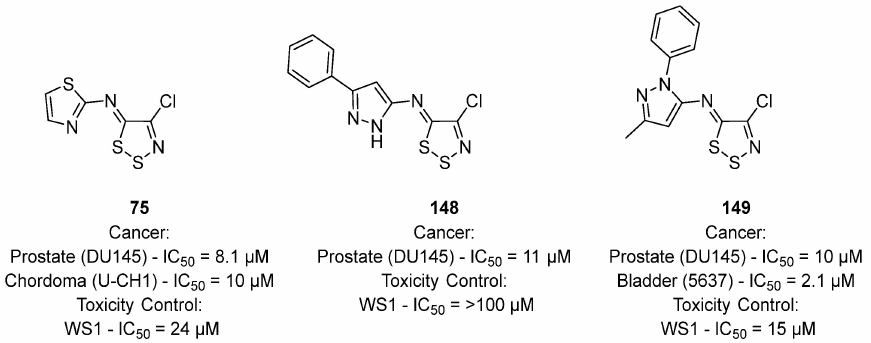
Figure 35. 5-membered heteroatomic analogues highlighted results from the 2021 cancer panel by our group [74].